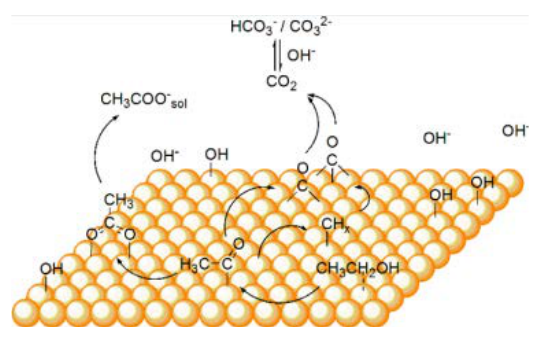
Figure 4. Reaction pathways for interfacial CH 3 CH 2 OH at Pd electrodes in alkaline media. Reproduced with permission from Reference [23]. Copyright 2014, American Chemical